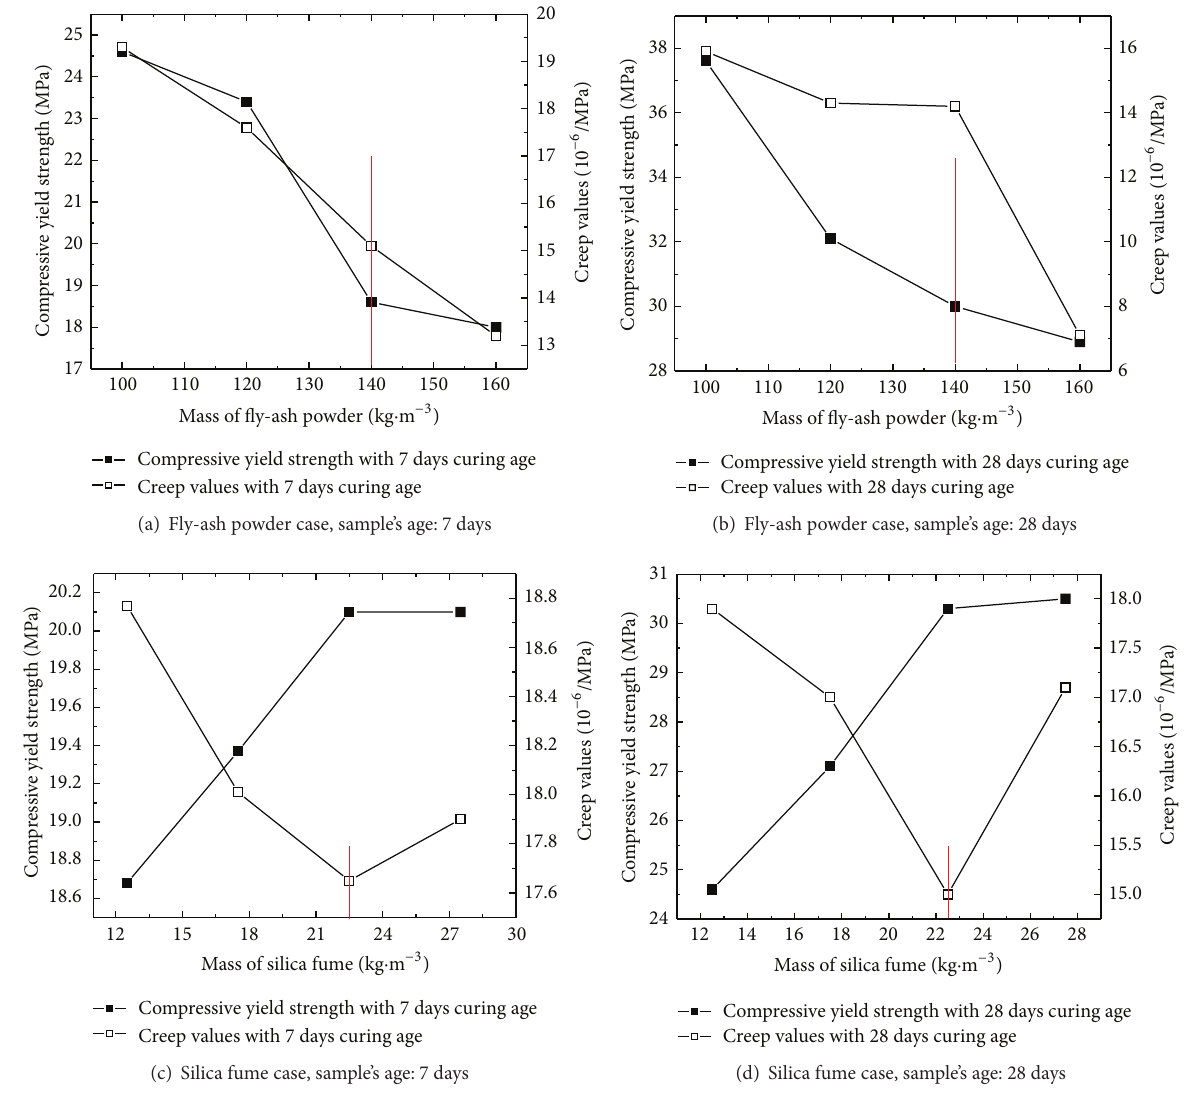
Figure 20: Compressive yield strength and thermodynamic characteristics